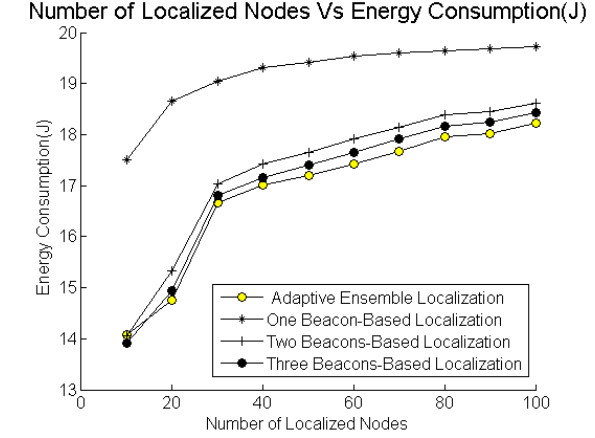
Figure 7. Number of localized nodes vs energy consumption (joule)